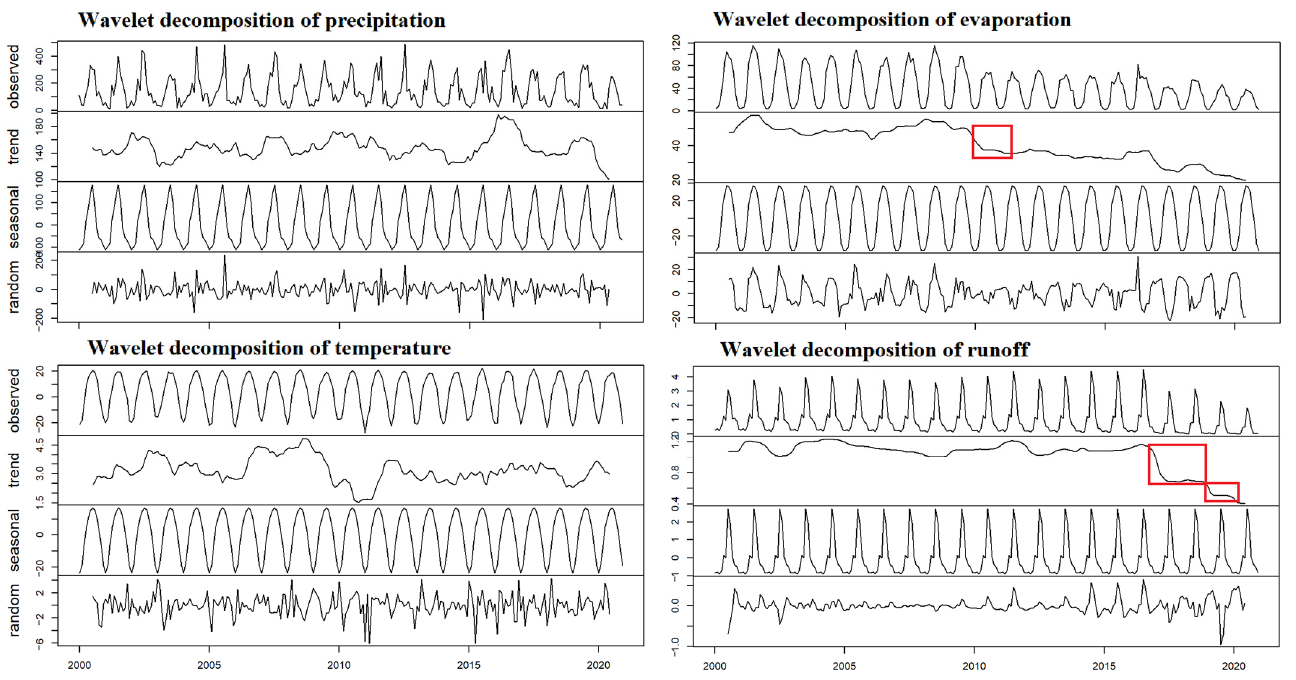
Figure 3. Periodic wavelet decomposition based on multi-year moving average. The red boxes represent significant downtrends, which were observed by stationarity test.